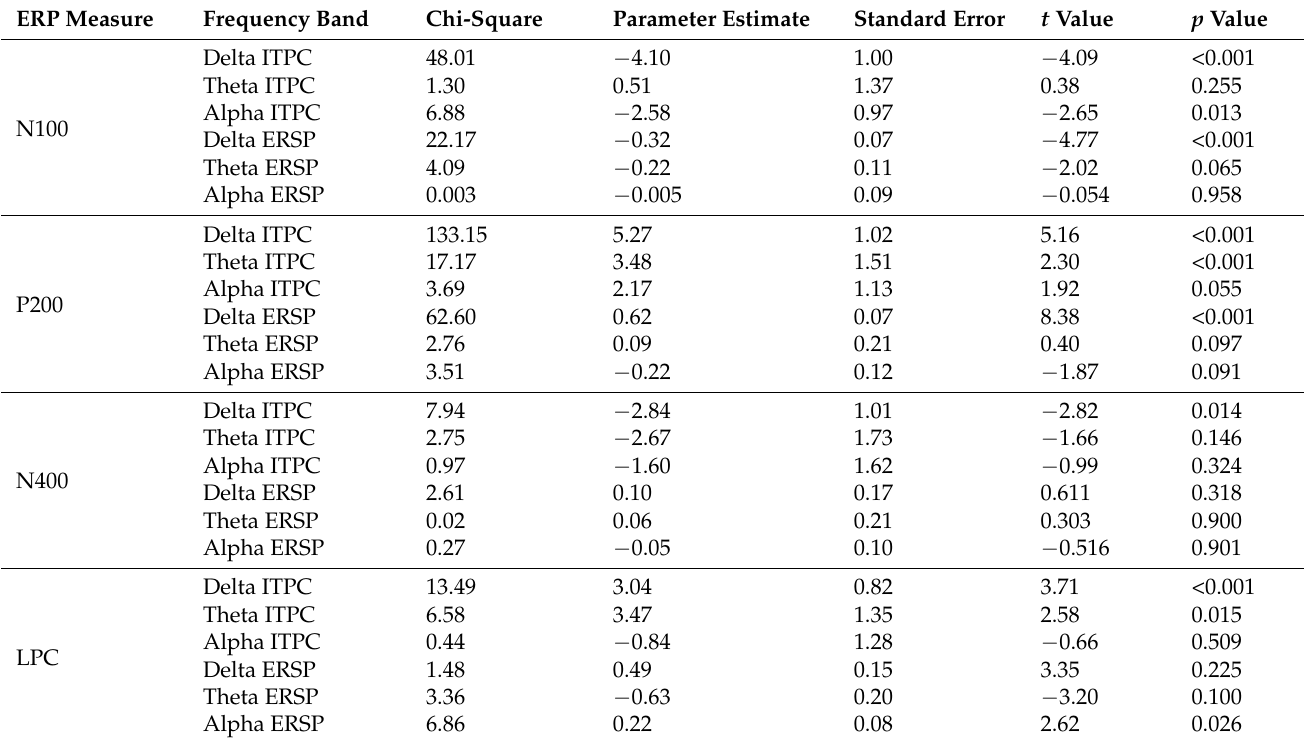
Table 4. Summary of LME models indicating the relationships between auditory ERP amplitude and neural oscillatory measures.